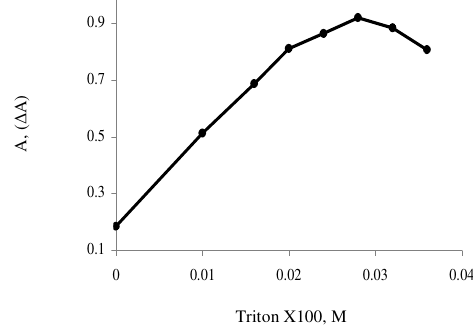
Figure 6. Influence of Triton- x -10 on the sensitivity.Conditions: 100 ng/mL V(V); H 0.8 M; MG, 1.72 × 10 -5 M; 1.2 × 10 -2 M BrO 3− ; temperature, 23 °C and time of 2.0 min from initiation of the